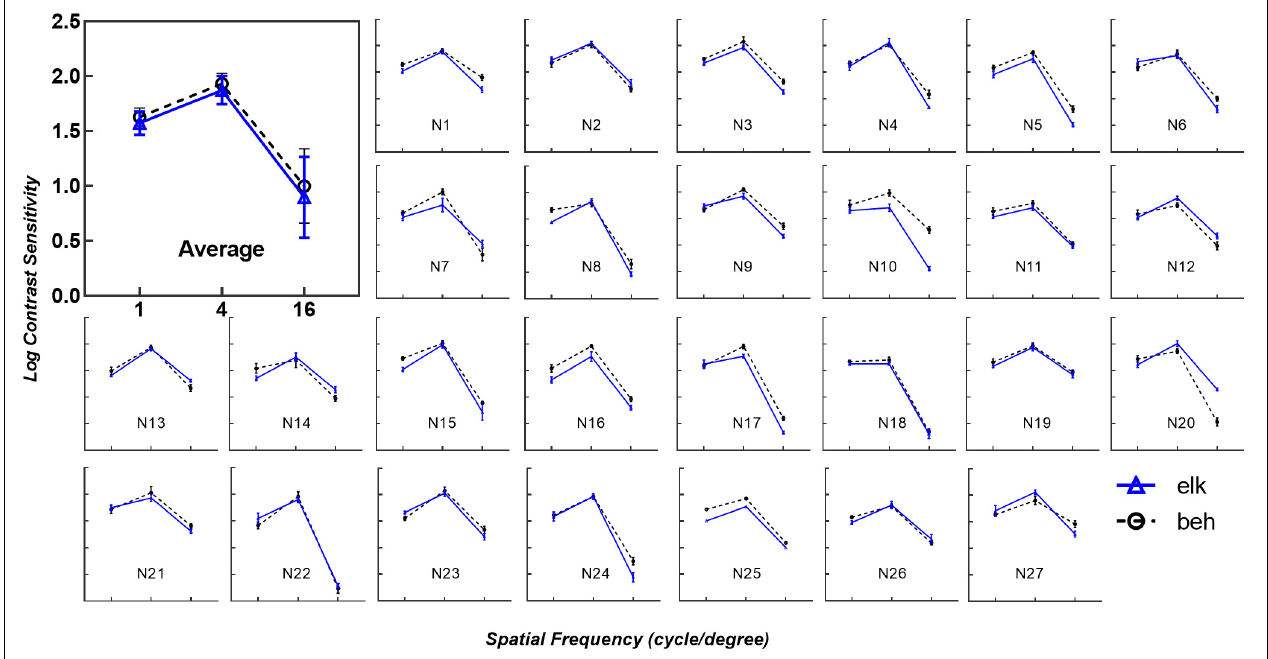
FIGURE 2 | Eye tracking logCS versus behavioral logCS under best-corrected visual acuity (BCVA). The average of all subjects’ data for each spatial frequency is shown in the first subplot (Average). The remaining subplots (N1 to N27) depict the logCS from each subject obtained from the eye tracking test (solid blue line with triangles, elk) and perceptual report (dashed black line with circles, beh) under BCVA. Error bars represent the standard deviation across last four reversals under each spatial frequency. The layout is consistent in each subplot, with the horizontal axes representing spatial frequency in log scale and the vertical axes representing log units of CS. In the average subplot, error bars represent the standard deviation across subjects under each spatial frequency. elk, eye tracking test; beh, behavioral test (conventional perceptual